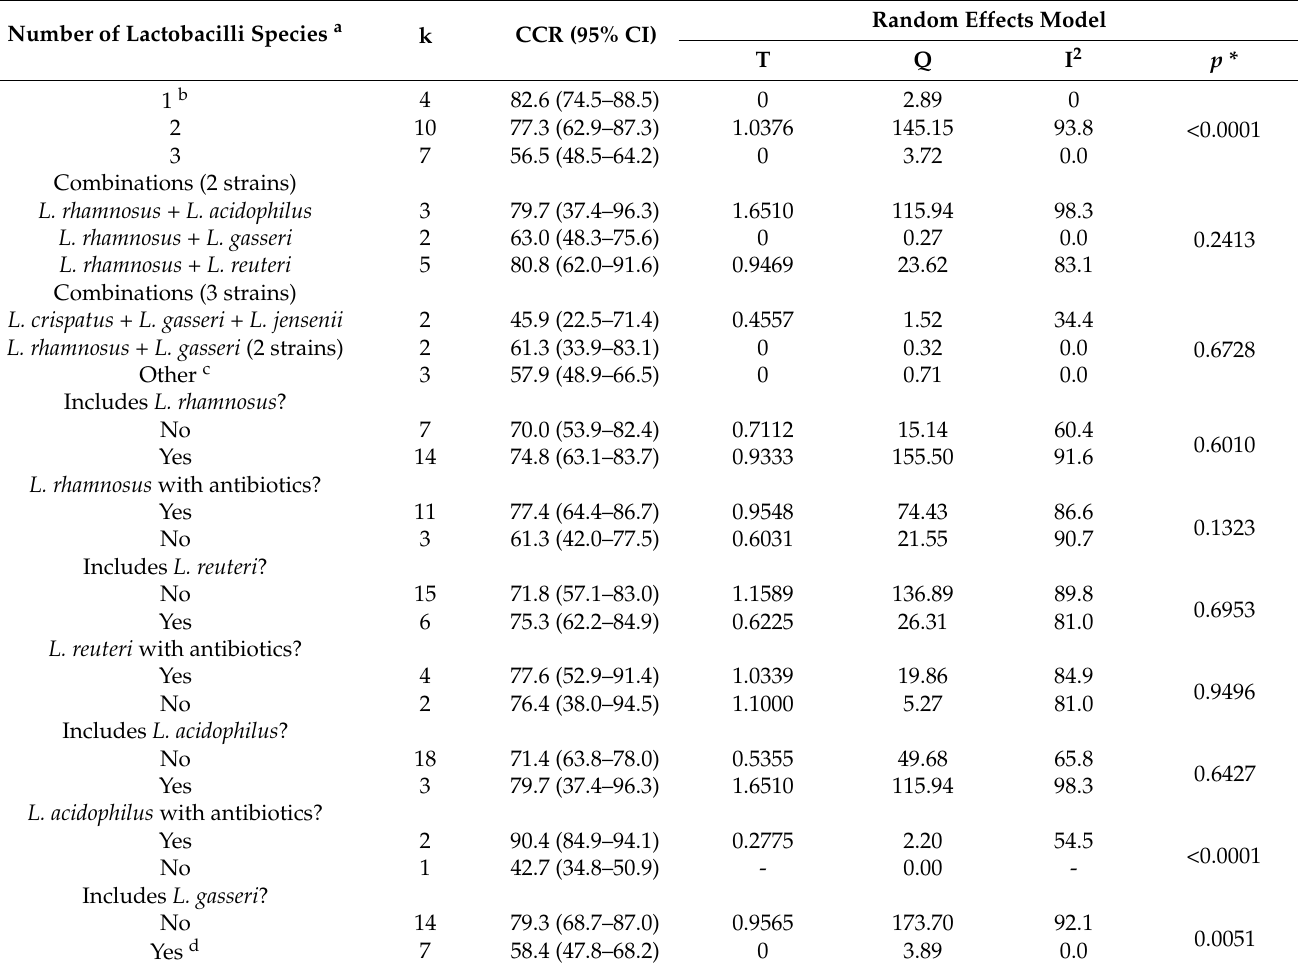
Table 4. Sub-group analysis of the efficacy in BV treatment with probiotic lactobacilli. Number of Lactobacilli Species